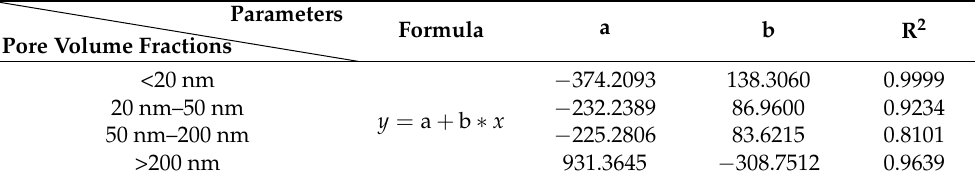
Figure 13. Relationship between fractal dimension and ( a ) porosity; ( b ) average pore diameter; ( c ) pore surface area; ( d ) pore diameter distribution. Table 8. Fractal dimension and pore size distribution fitting result parameters.